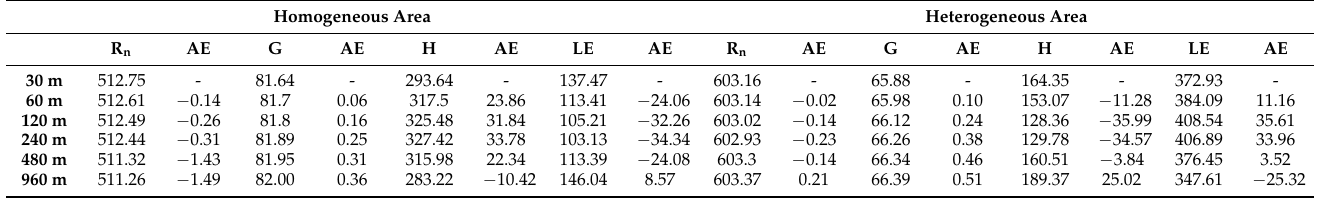
Table 5. Statistical results of the energy fluxes in the homogeneous and heterogeneous areas at different spatial resolutions. Homogeneous